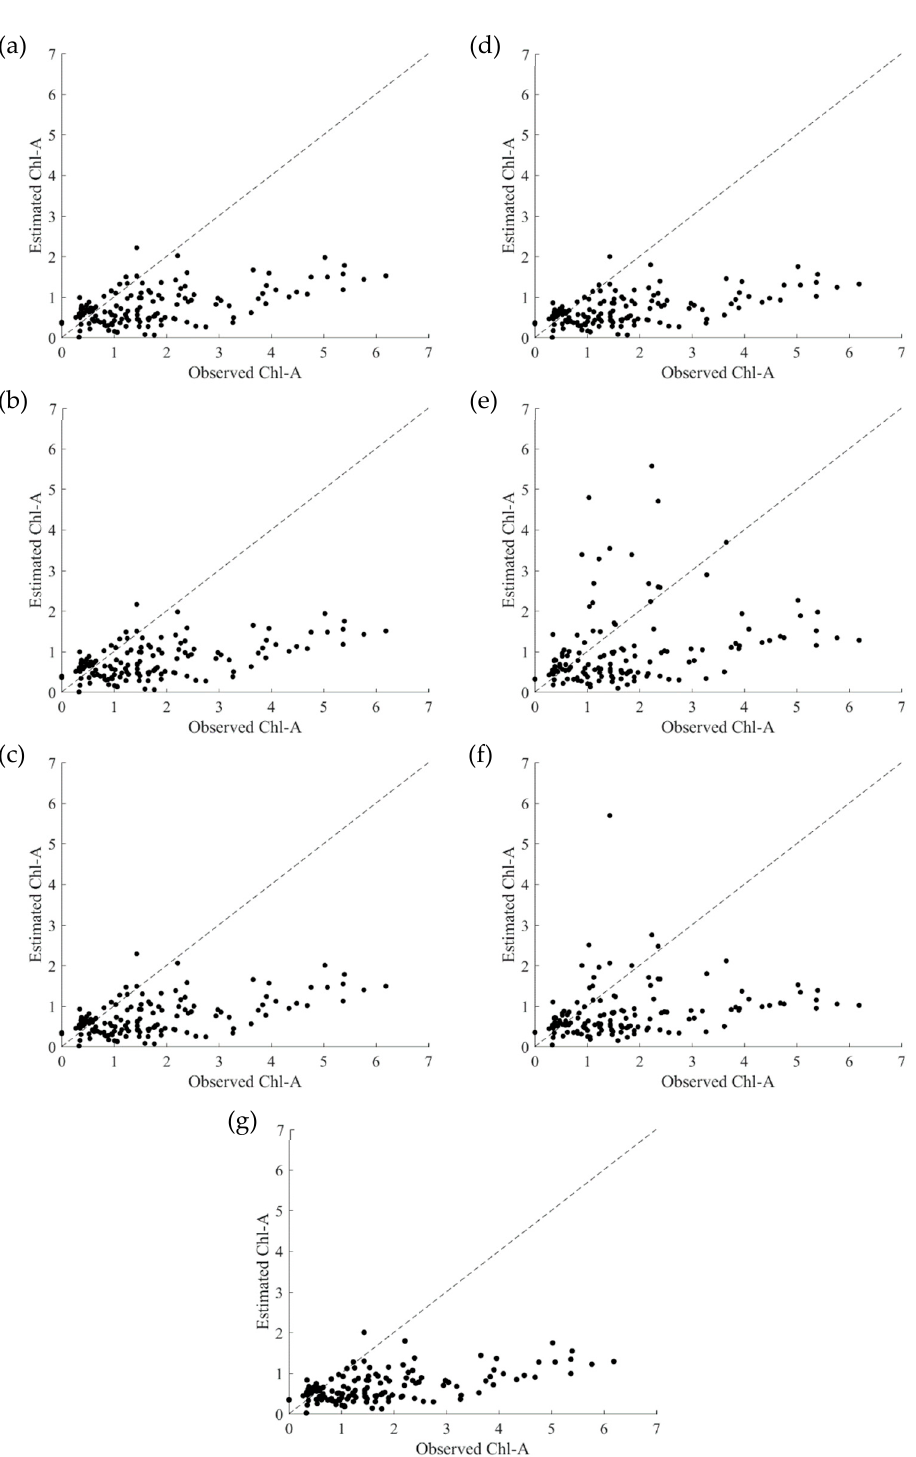
Figure 3. Scatter plots of in situ and estimated chl-a for OC algorithms. Used algorithms: ( a ) OC1a,